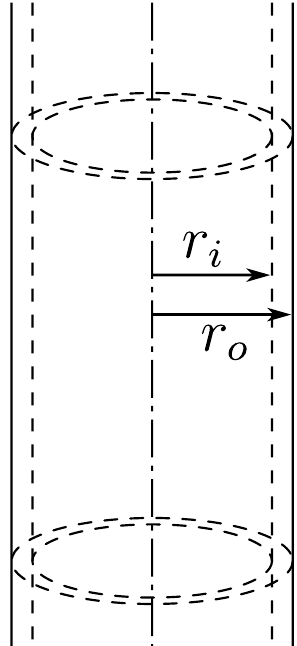
Figure 3. Infinitely-long cylinder model.